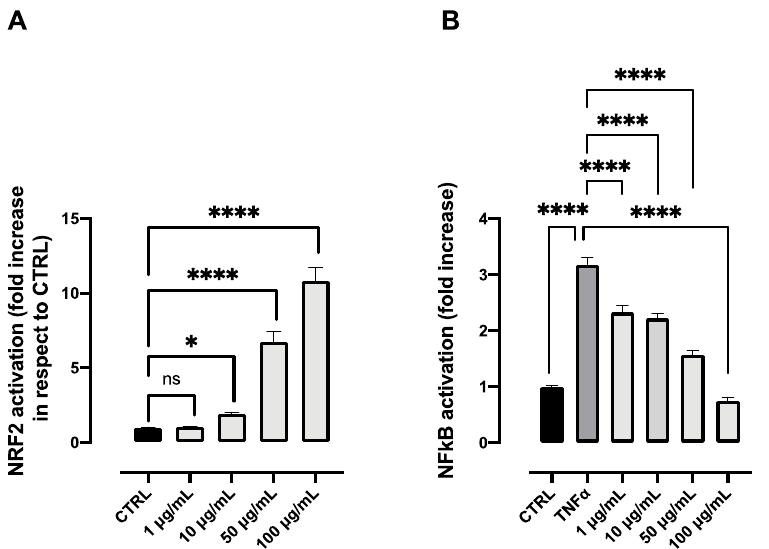
Figure 9. NRF2 activation ( A ) and anti-inflammatory activity ( B ) of different concentrations of the aqueous extract obtained from the flower head of Achillea moschata . Data are reported as mean ± SD. The statistical significance difference of each concentration in respect to the control was analyzed by one-way ANOVA followed by the Bonferroni post-test. * p < 0.05, **** p < 0.0001, ns = not significant.